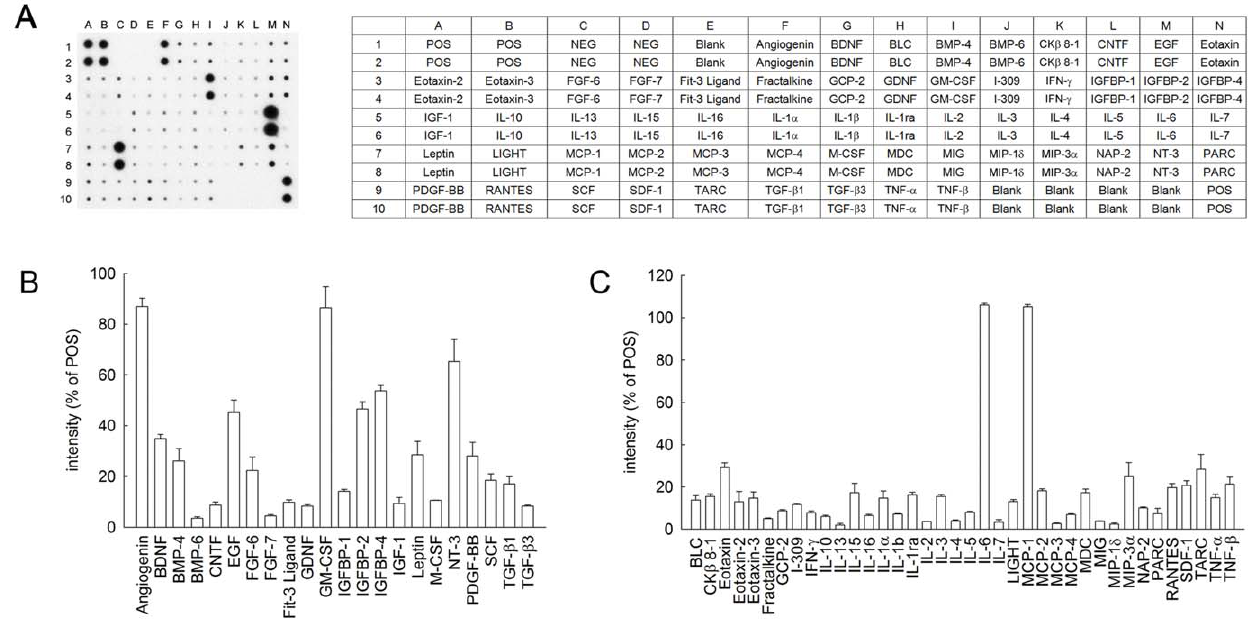
Figure 2. Secretion profile of growth factors and cytokines from immortalized hMSCs. Immortalized hMSCs were cultured in DMEM/LG medium for 48 hours. The cultured media were collected and applied onto a human growth factors/cytokines antibody array membrane (left panel in A). The map of the array that is designed to detect 60 cytokines, chemokines, or growth factors is shown in A (right panel). The arrays were scanned, and the staining intensity of each spot was quantified by densitometry. The percentage of the intensity of the respective spots over that of the positive control (POS) on the same array was represented as the relative expression levels of each human growth factor (B) or cytokine (C). The data represent mean 6 SEM of three independent experiments.